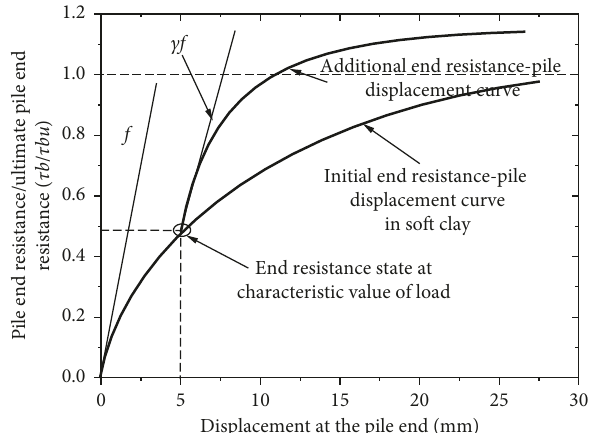
Figure 6: Calculation model of end resistance and displacement of